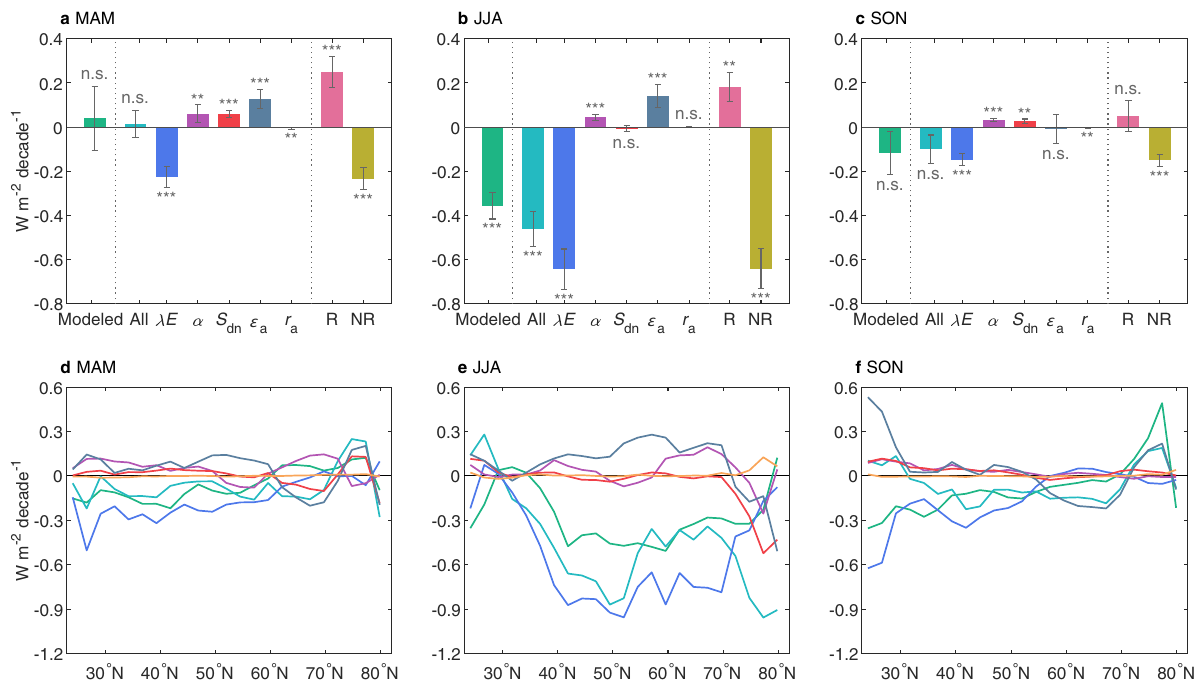
Fig. 4 Biophysical processes underlying intra-seasonal temperature responses to greening. a – c Linear trends in surface radiative forcing associated with changes in latent heat fl ux ( λ E ), surface albedo ( α ), aerodynamic resistance ( r a ), shortwave radiation ( S dn ), and air emissivity ( ε a ) induced by leaf area index (LAI) changes within the same season. d – f Latitudinal variation in surface radiative forcing associated with different biophysical processes. “ All ” indicates the sum of all surface radiative forcings; “ R ” and “ NR ” indicate surface radiative forcing associated with radiative and non-radiative processes, respectively. *** p < 0.01; ** p < 0.05; * p < 0.1; n.s., p > 0.1. MAM March-April-May, JJA June-July-August, SON September-October-November,